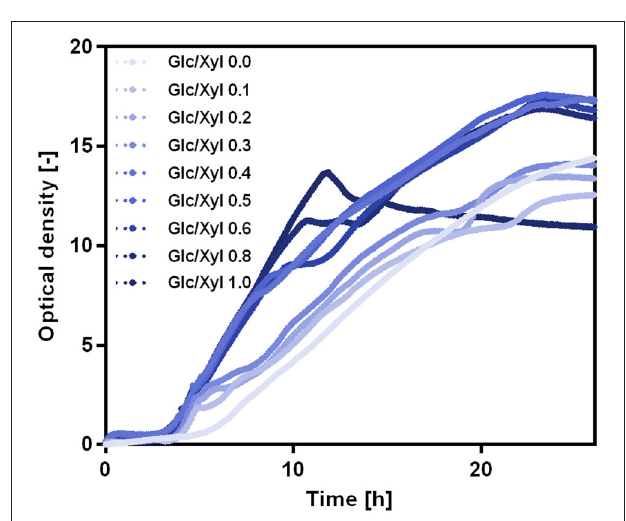
FIGURE 10 | Growth curves for B. subtilis WB PX43- pgs with varying substrate ratios. The total substrate of 20g L − 1 was varied from 0 to 100% glucose (light blue to dark blue). The cultivations were carried out in 500mL shake flasks with 50mL filling volume and 200 rpm shaking frequency. The growth curves were monitored online using the CGQ (Aquila Biolabs). The data represent the mean of triplicate